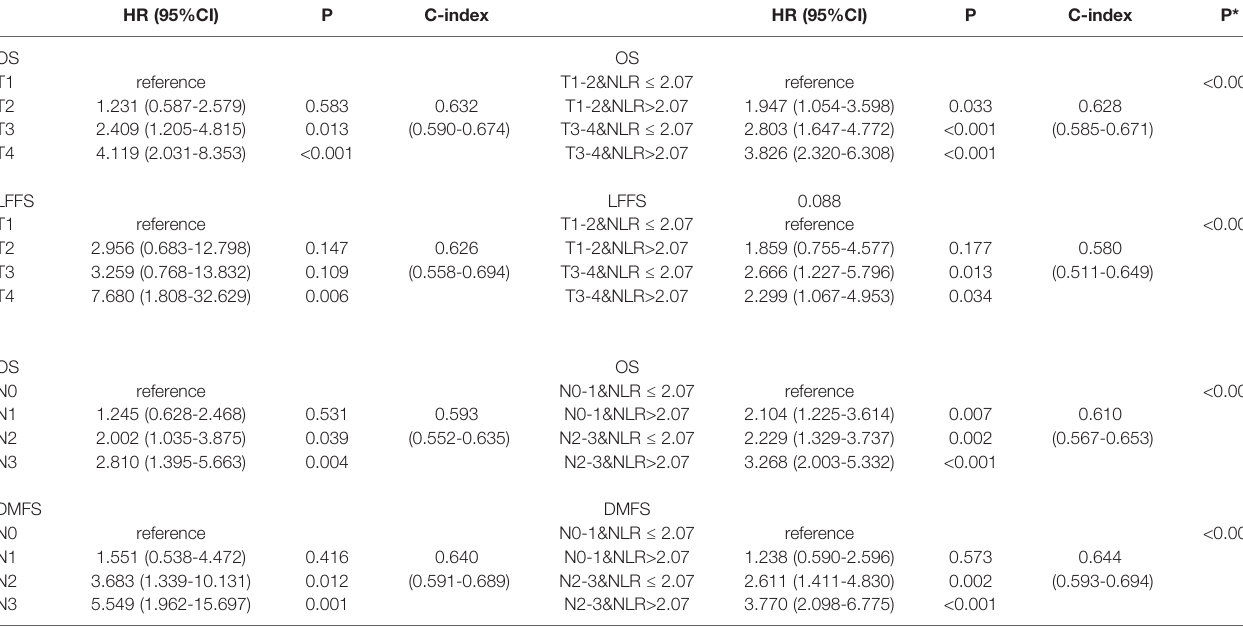
TABLE 3 | Univariate analysis for T and N classi fi cations associated with overall survival, local failure-free survival, and distant metastasis free survival. HR